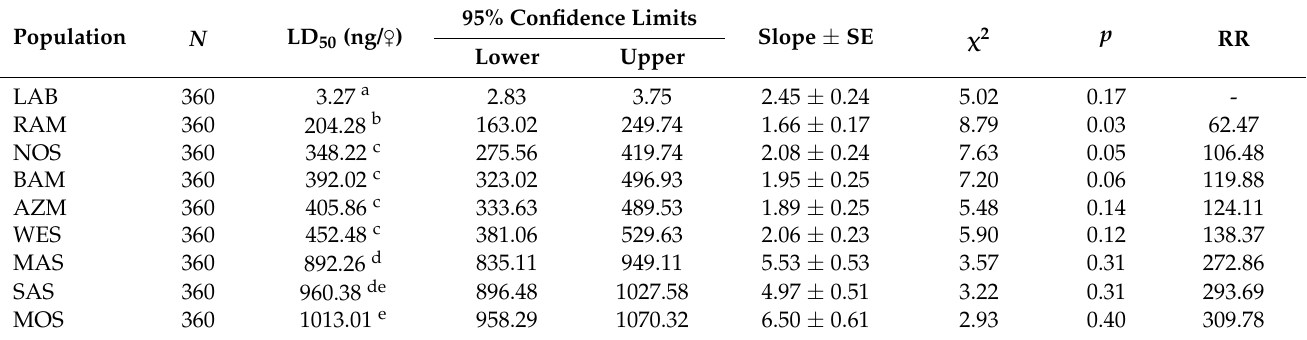
Table 2. Median lethal doses (LD 50 ) and resistance ratio (RR) of Musca domestica treated with diazinon.